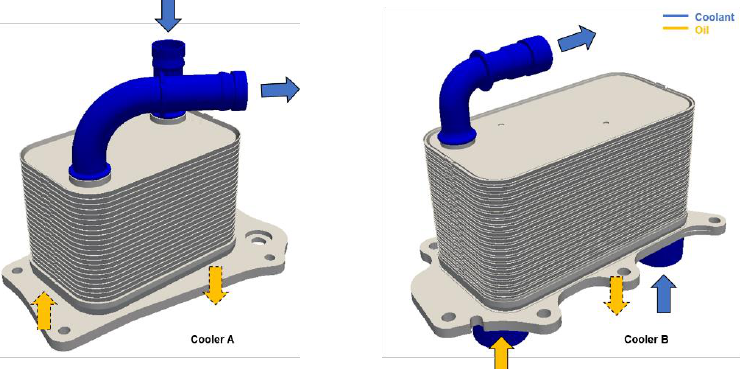
Figure 5. Integration between the simulations performed at the different scales.